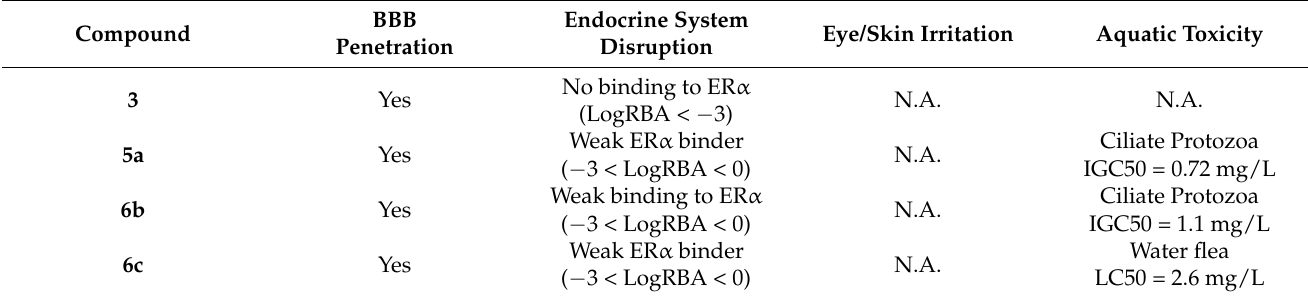
Table 4. Toxicological endpoints selected for the hazard identification procedure. For each compound, BBB penetration, endocrine system disruption, eye/skin irritation, and aquatic toxicity were predicted using the ACD/Percepta